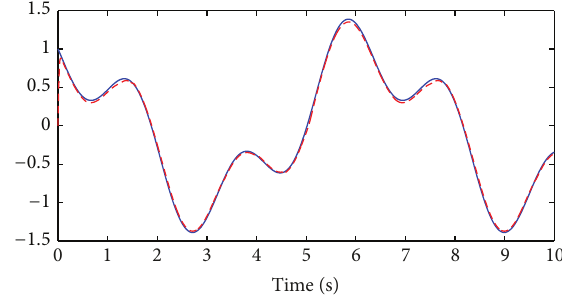
Figure 2: Tracking process: reference trajectory 𝑥 𝑟,2 (𝑡) , solid line; system state 𝑥 2 (𝑡) , dashed line.